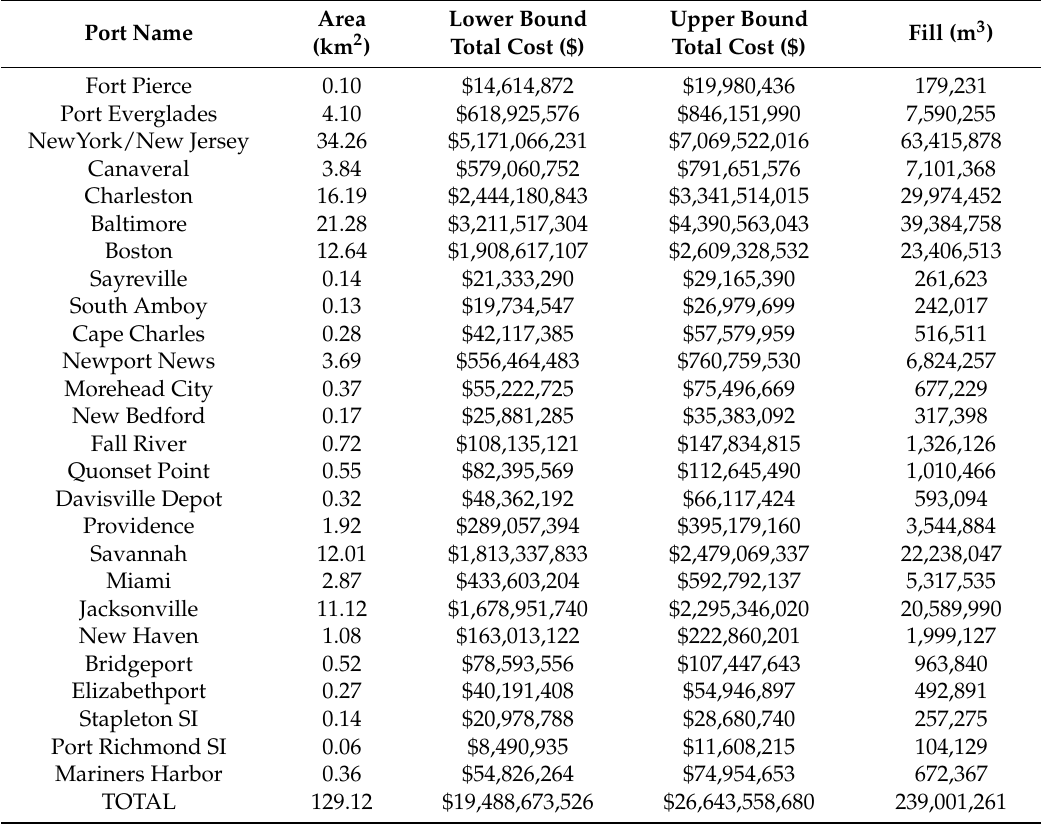
Table A3. Cost and materials required to elevate and retrofit East Coast Seaports in response to two meters of sea level